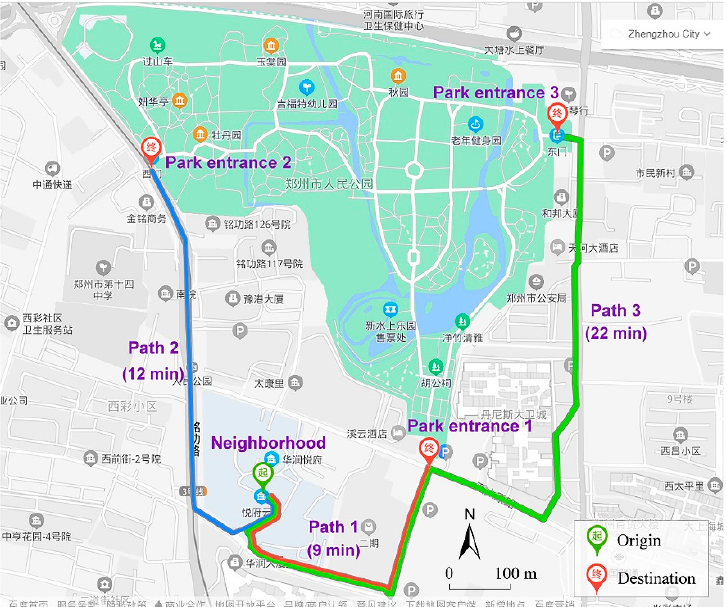
Figure 4. Example of travel path and time cost visualization in walking mode of Baidu Maps Navigation.